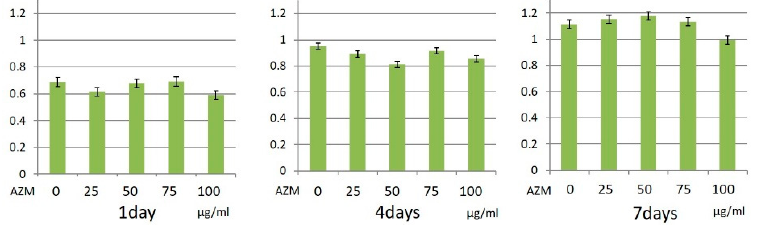
Figure 4. Cell proliferation ability of human periodontal ligament fibroblasts (hPLFs) with AZM. These experiments were performed in triplicate, and data are presented as the mean ± SD.